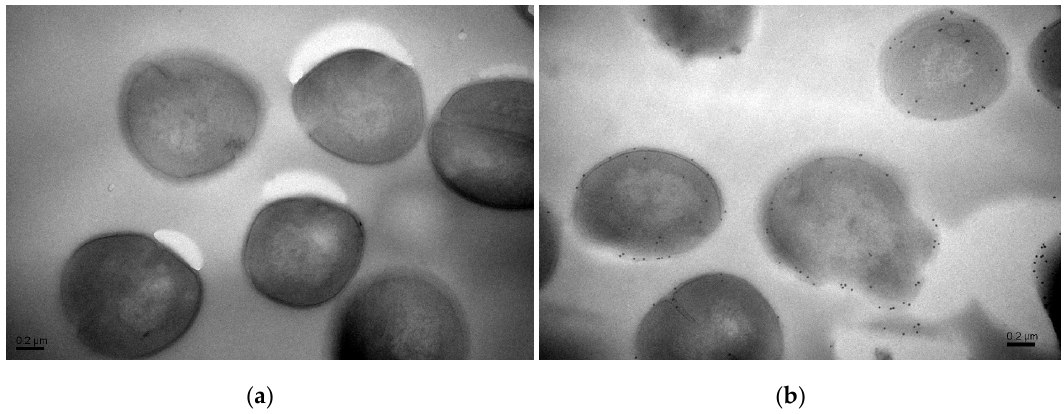
Figure 4. The locations of pBD2 on bacteria were detected by immuno-gold TEM. ( a ) Control cells; ( b ) cells after they were treated with 150 μ g/mL pBD2 for 4 h. The gold particles labeling the secondary antibody indicate the location of pBD2.